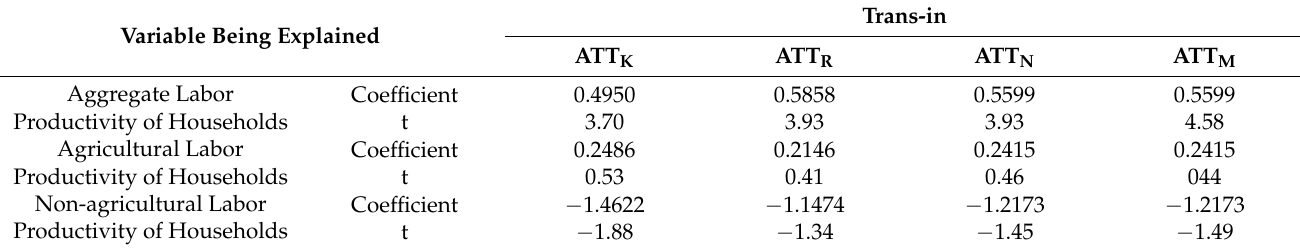
Table 10. Basic Estimation Results of ATT for the Productivity of Land Transfer-in